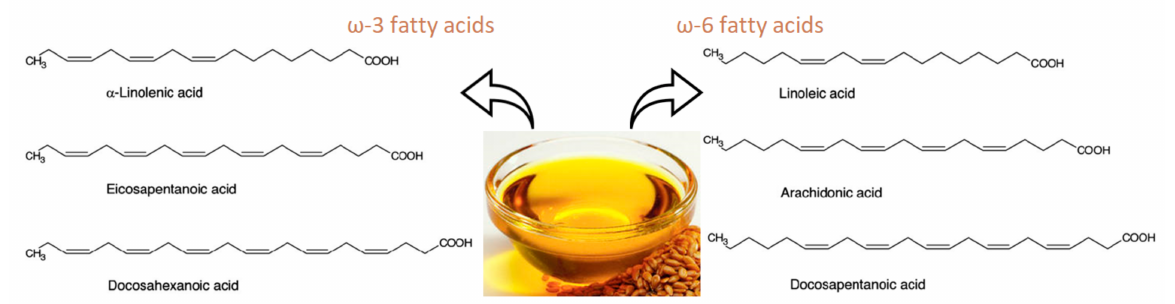
Figure 1. Different types of ω -3 and ω -6 fatty acids present in flaxseed oil (self-developed, the concept was adopted from [5]).